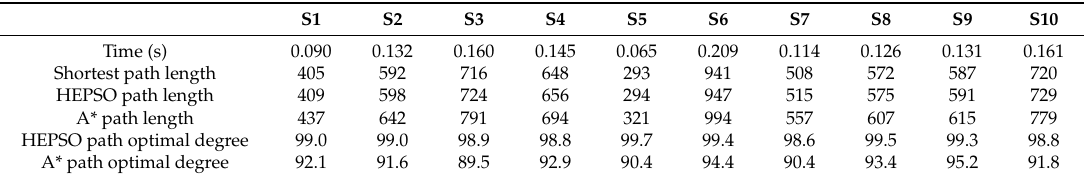
Table 2. Data of path planning on distinct